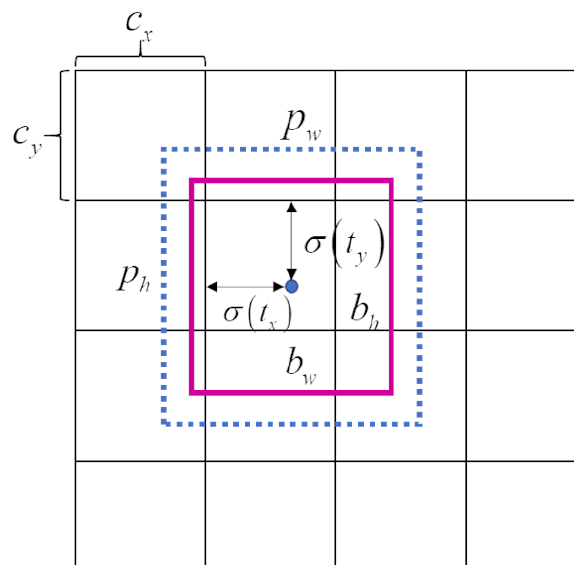
Figure 2. Bounding box